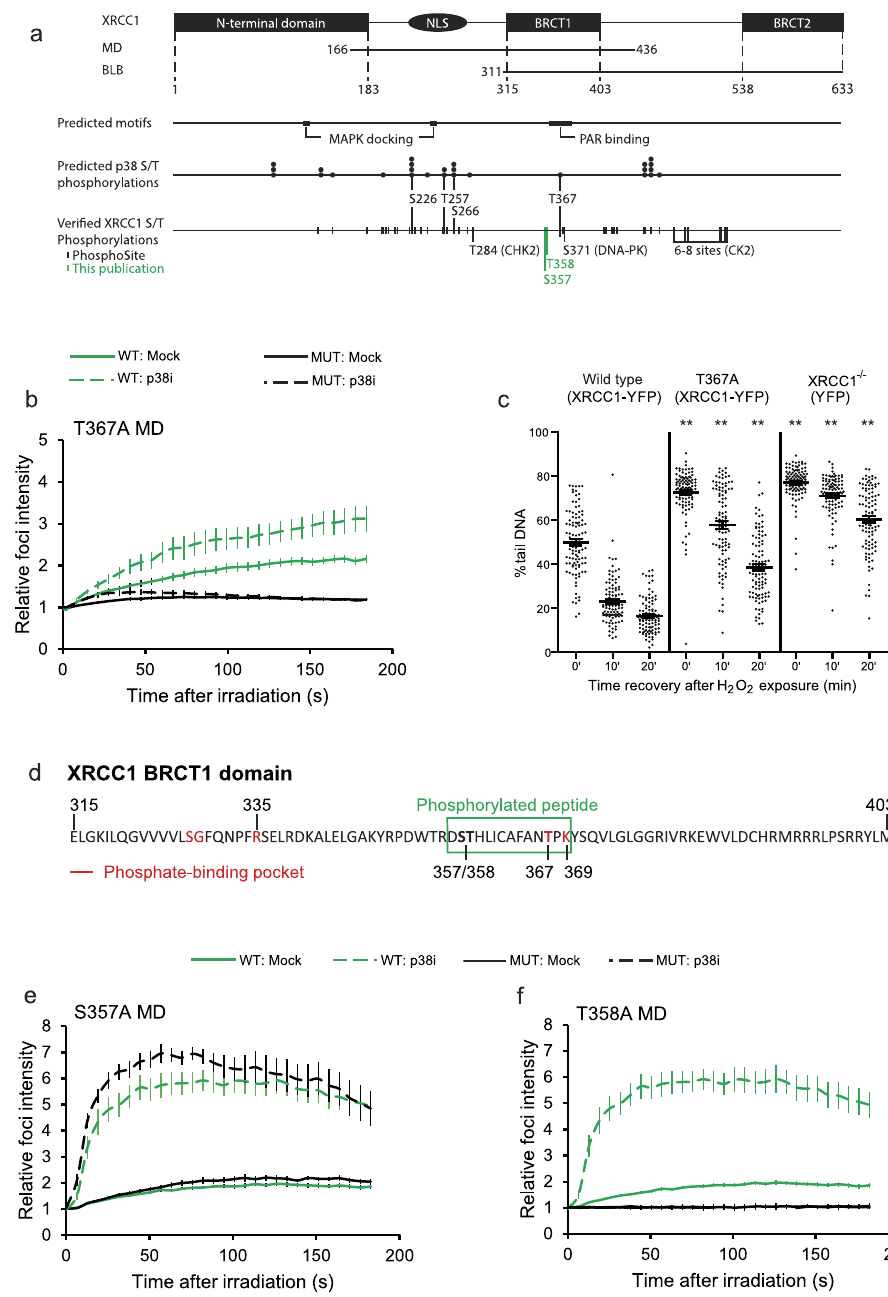
Figure 4. Mutation of XRCC1 phosphorylation sites and recruitment to DNA damage. ( a ) Map of XRCC1: known domains, deletion mutants, predicted MAPK docking motif, PAR-binding region, predicted p38 MAPK and known phosphorylation residues. Phosphorylation residues identified in this publication is marked in green. ( b ) Average fold increase in mIF intensities of wild type YFP-MD (WT, green lines) and mutant YFP-MD T367A (MUT, black lines) in mock and p38i (SB203580, 25 µ M) treated CHO EM9 cells using 1x laser dose. WT: Mock n = 19, p38i n = 12. MUT (T367A): Mock n = 17, p38i n = 16. Mean ± SEM. ( c ) Comet analysis: Dot plot of CHO EM9 cells expressing XRCC1-YFP wild type, XRCC1-YFP T367A and YFP treated with H 2 O 2 (62 µ M) for 10 min. 0, 10 and 20 min recovery. Averages of n = 100 ± SEM. One out of three similar experiments is shown. Asterisks represent Student’s t-test p-values from cells with mutated or no XRCC1 vs. the corresponding XRCC1 wild type sample, where ** p < 0.001. ( d ) Sequence of the XRCC1 BRCT1 domain. The phosphorylated peptide detected on MS (green box) and the phosphate-binding pocket (red) are indicated. ( e , f ) Average mIF intensities of wild type YFP-MD (WT, green lines) and YFP-MD T357A ( e ) and T358A ( f ) mutants (MUT, black lines) in mock and p38i (SB203580, 25 µ M) treated HeLa cells using 1x laser dose. WT: Mock n = 16, p38i n = 10. S357A: Mock n = 16, p38i n = 11. T358A: Mock n = 8, p38i n = 4. Mean ±